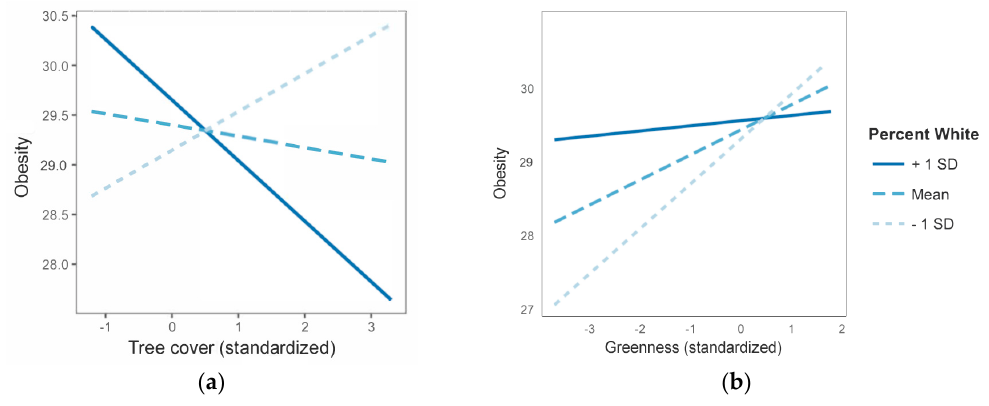
Figure 2. Interaction between percent non-Hispanic White residents in a city and ( a ) tree cover and ( b ) overall greenness on obesity rates. Findings are shown for our full sample of cities. Solid blue lines show the greenspace-health relationship for cities with one standard deviation greater than the mean regarding percentage of non-Hispanic Whites. Light blue dotted lines show the same relationship for cities with one standard deviation less than the mean. Importantly, subsample analyses suggest majority-non-Hispanic Black cities show the opposite effect as the full sample results shown in this figure; in majority non-Hispanic Black cities, there is a positive (not negative) association between health and greenspace (results not depicted in figures but reported in the text). Table 5. Findings from subsamples of cities with majorities of one race/ethnicity.